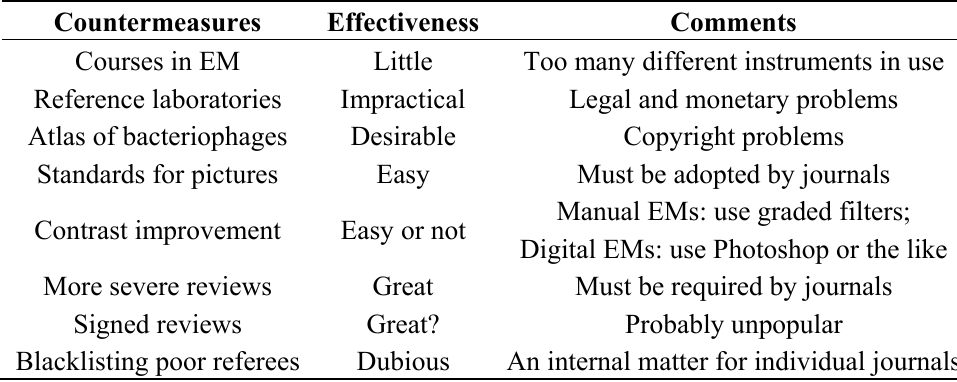
Table 5. Possible